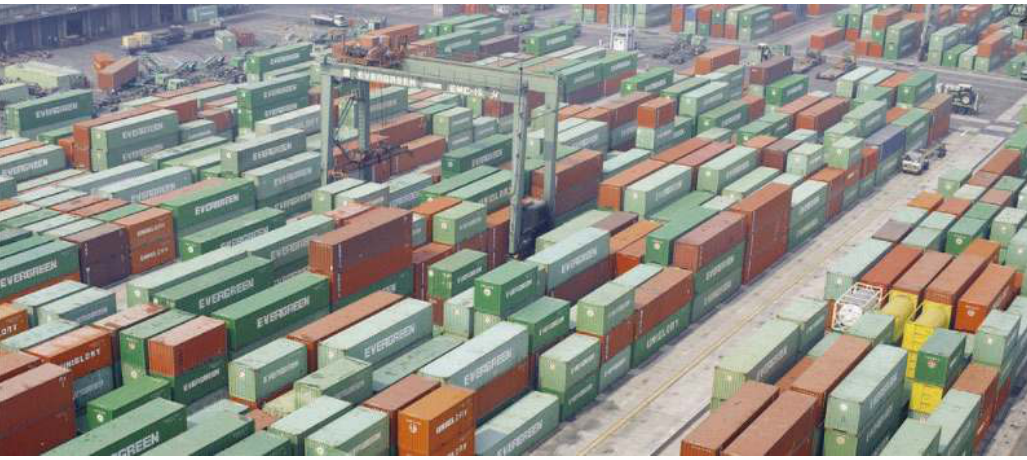
Fig. 10 Crane system in a container yard.